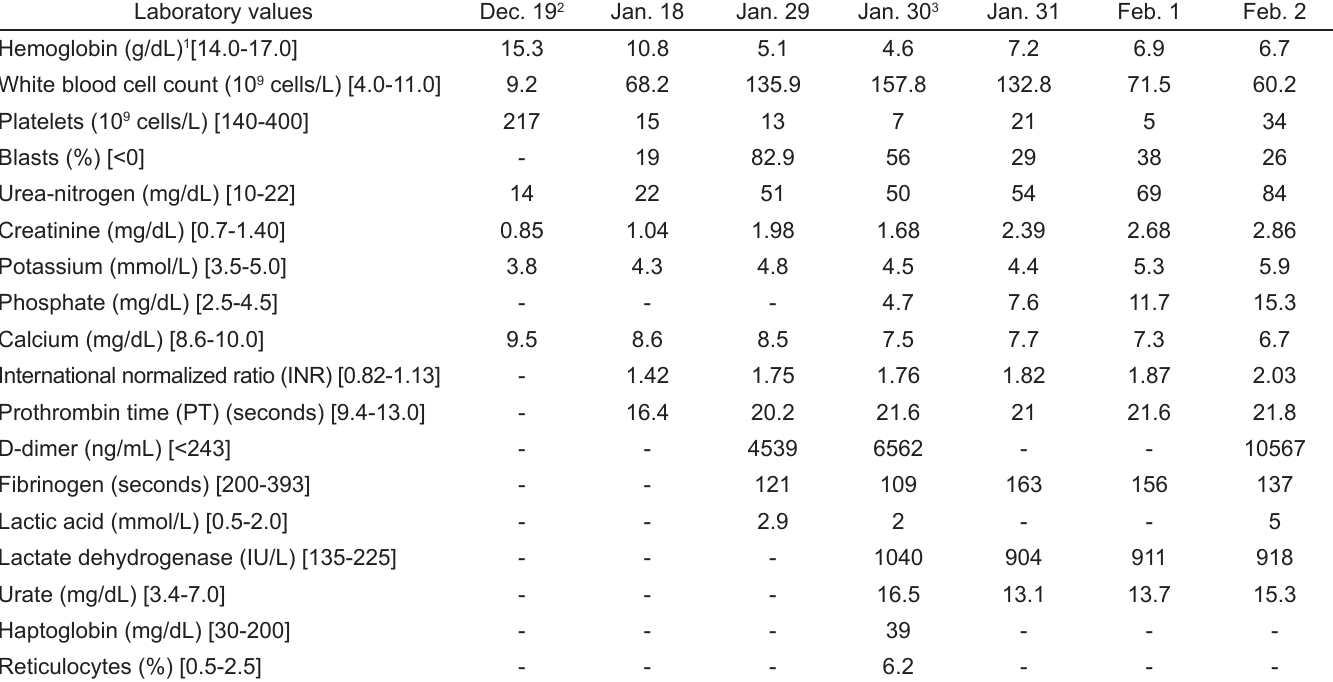
Table 1. Patient’s laboratory values during hospitalization. Laboratory